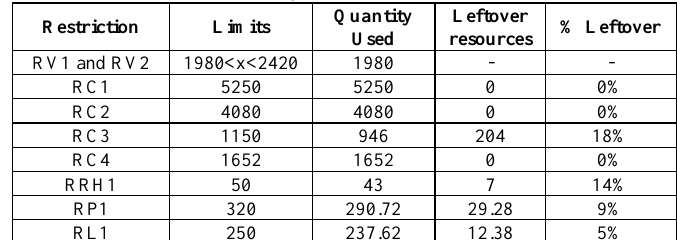
Table 3: Analysis of excess